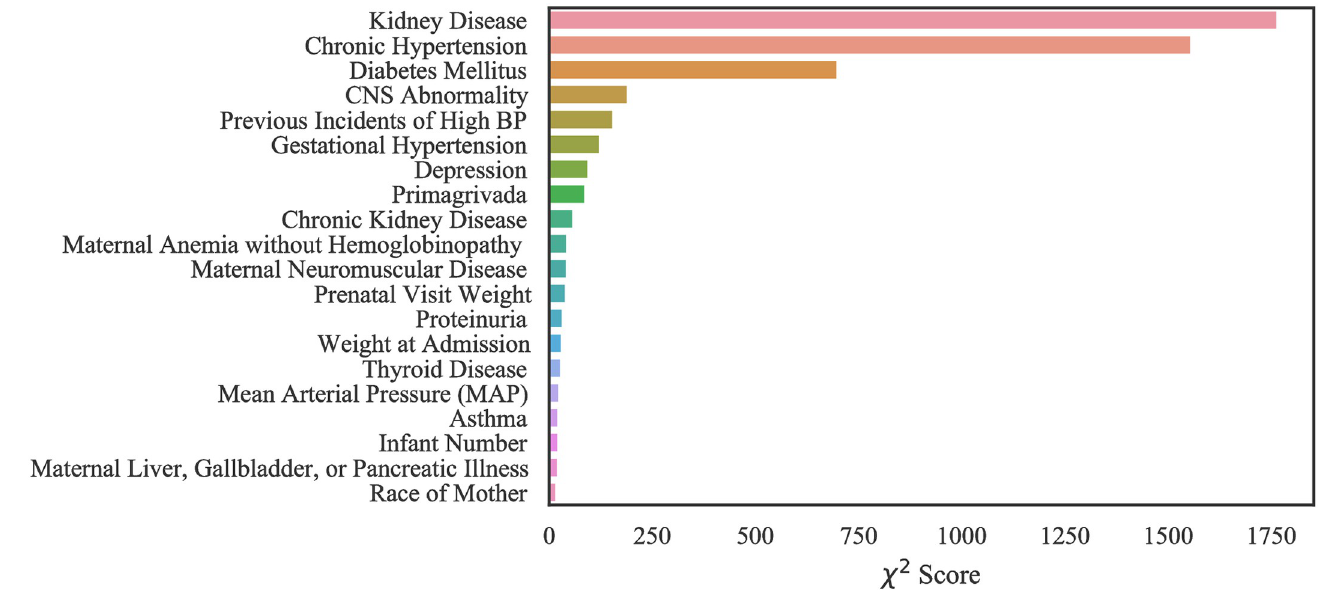
Fig 16. Feature ranking for the MOMI Full